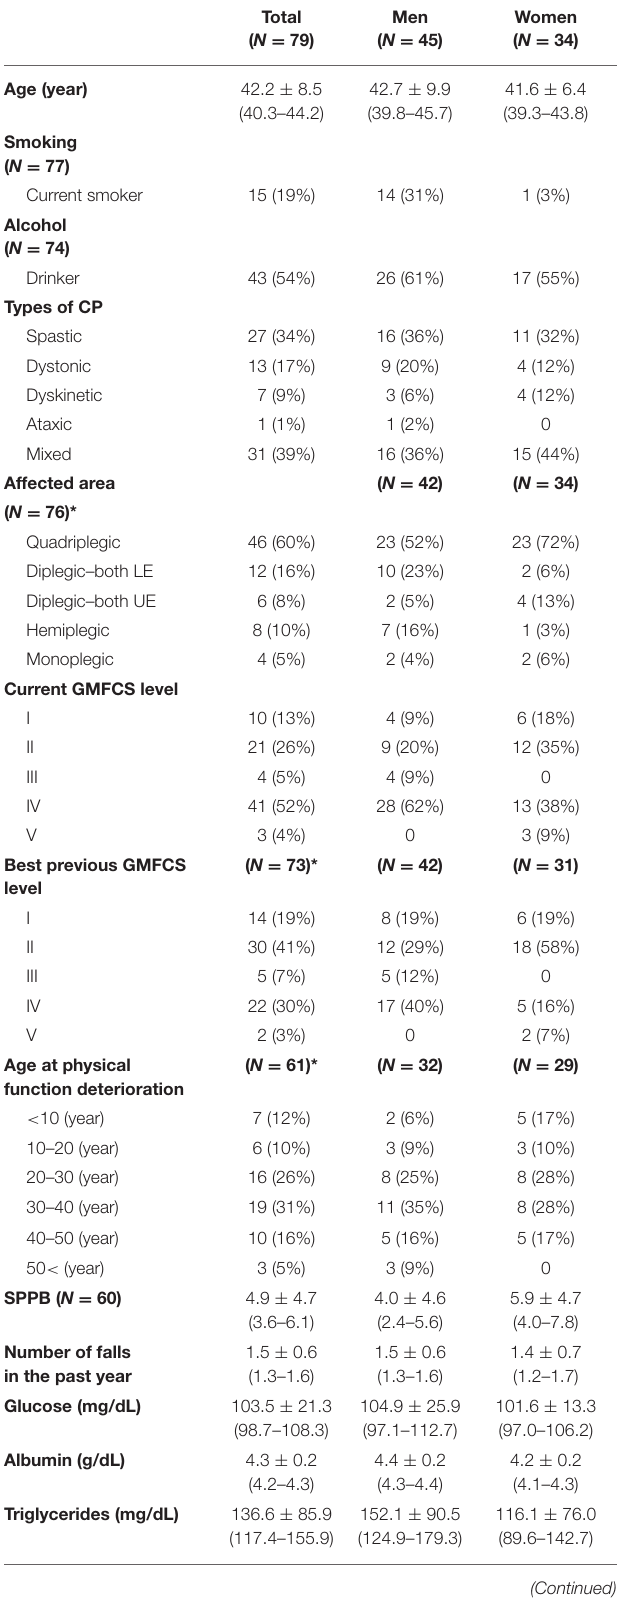
TABLE 1 | Participant’s characteristics, physical function, and laboratory results.